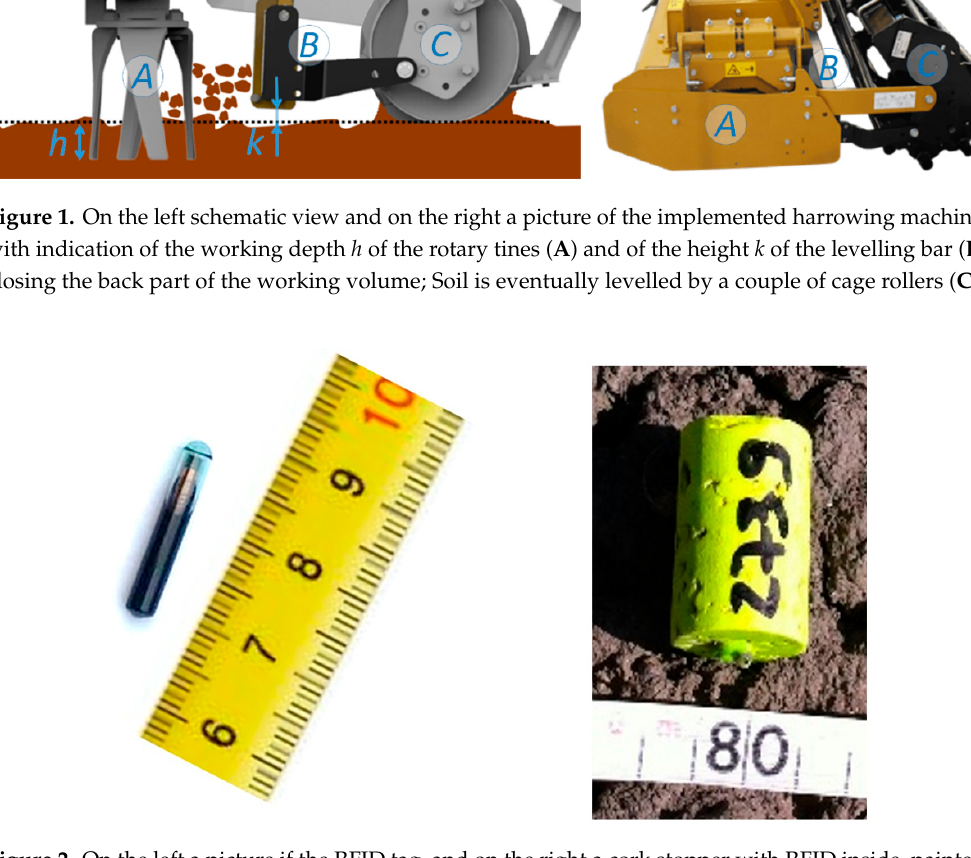
Table 1. Experimental conditions.